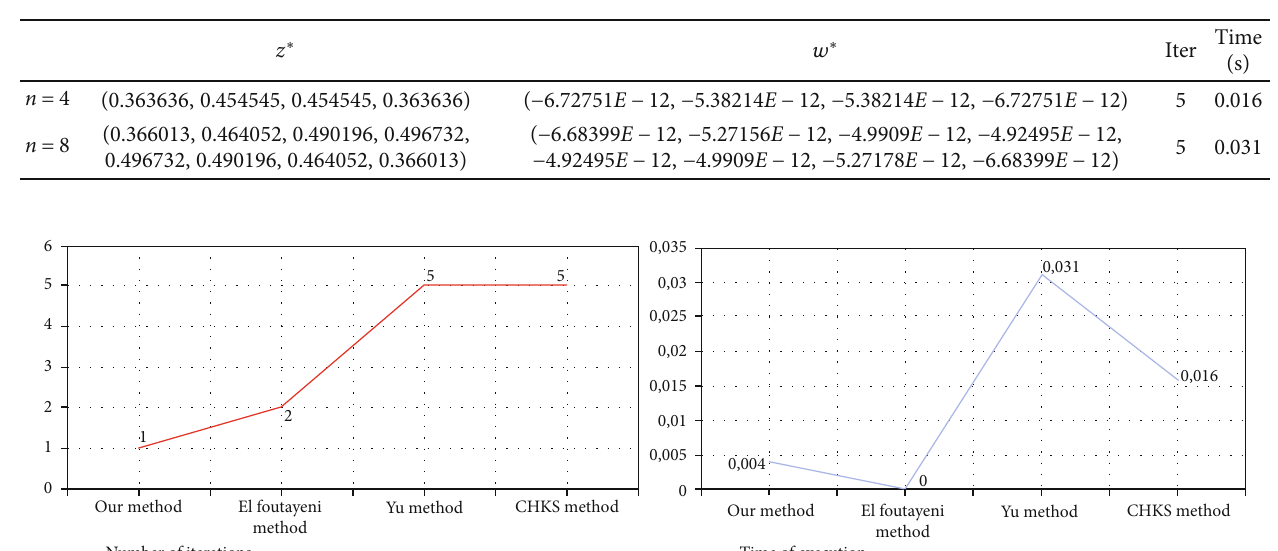
Table 4: Numeric outcomes of the CHKS method.